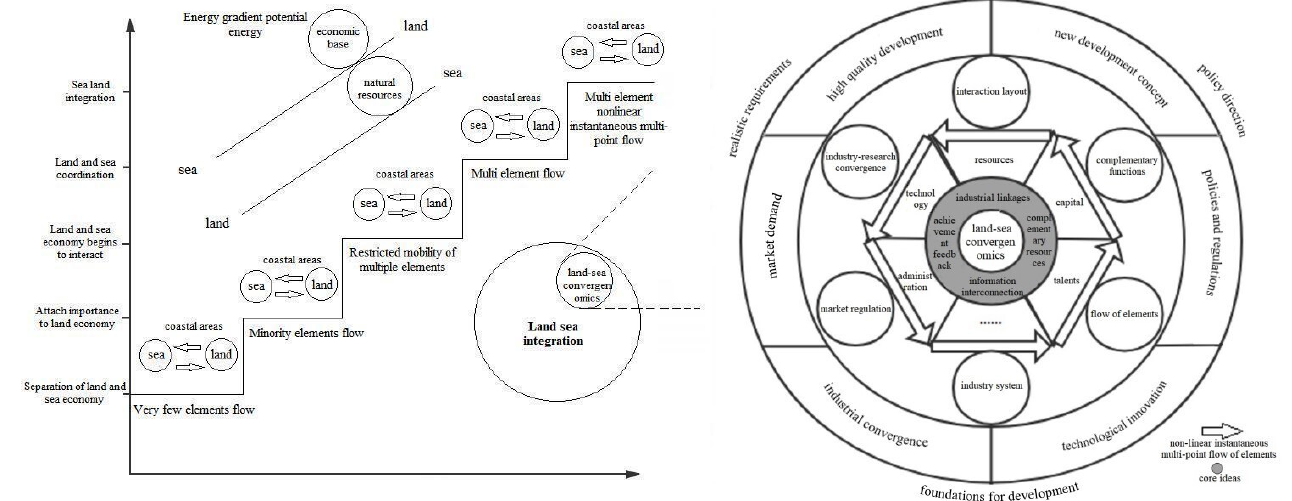
Figure 2. Conceptual relationship of the sea–land integration economy and evolution of the related development context. Source: own elaboration on the basis of 3.1 Chapter literature and theory.